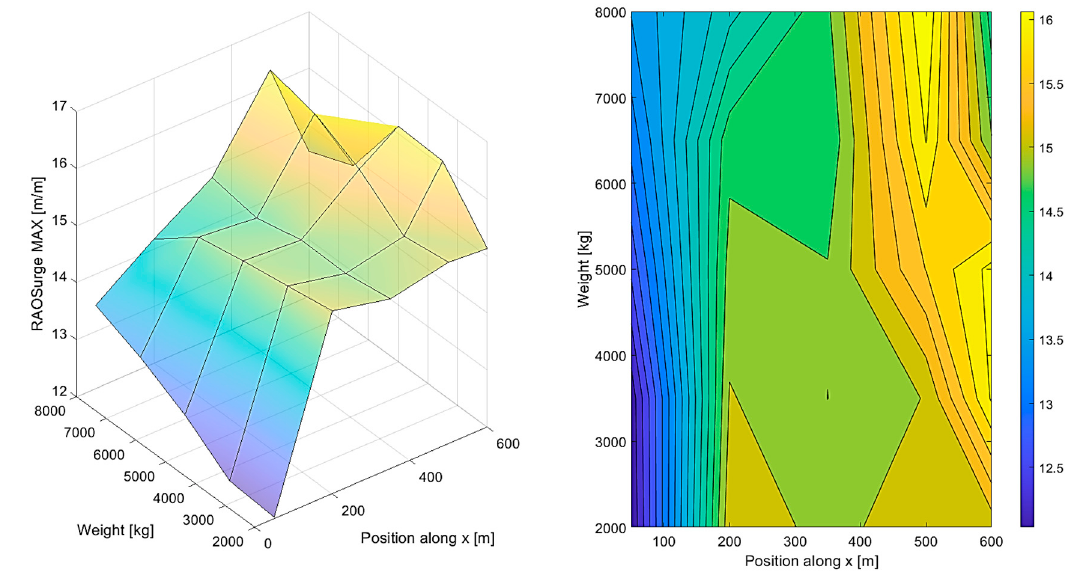
Figure 4. Peak of the Surge motion’s RAO using 5 different positions and 5 different masses.